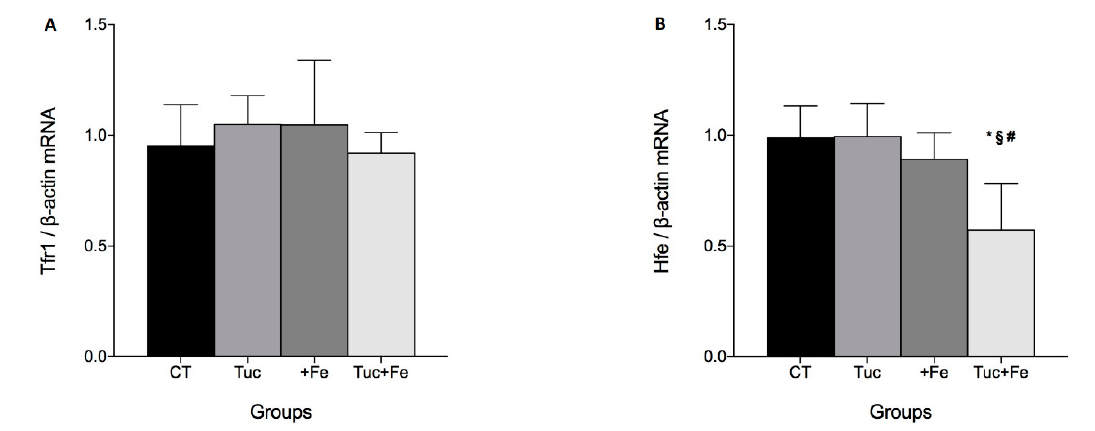
Figure 3. Hepatic mRNA level quantification of transferrin receptor ( Tfr1 )( A ) and hereditary hemochromatosis protein homolog ( Hfe ) ( B ) mRNA levels in rats fed control diet, tucum-do-cerrado (Tuc), iron-enriched diet (+Fe), or tucum-do-cerrado iron-enriched diet (Tuc+Fe), for 12 weeks. Data are the average ± standard deviation ( n = 6). Statistical differences compared to: * CT group; # Tuc group, and § +Fe group and ( p < 0.05).